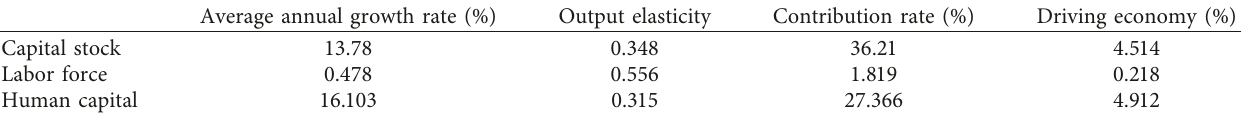
Table 5: Contribution of various factors to economic growth.